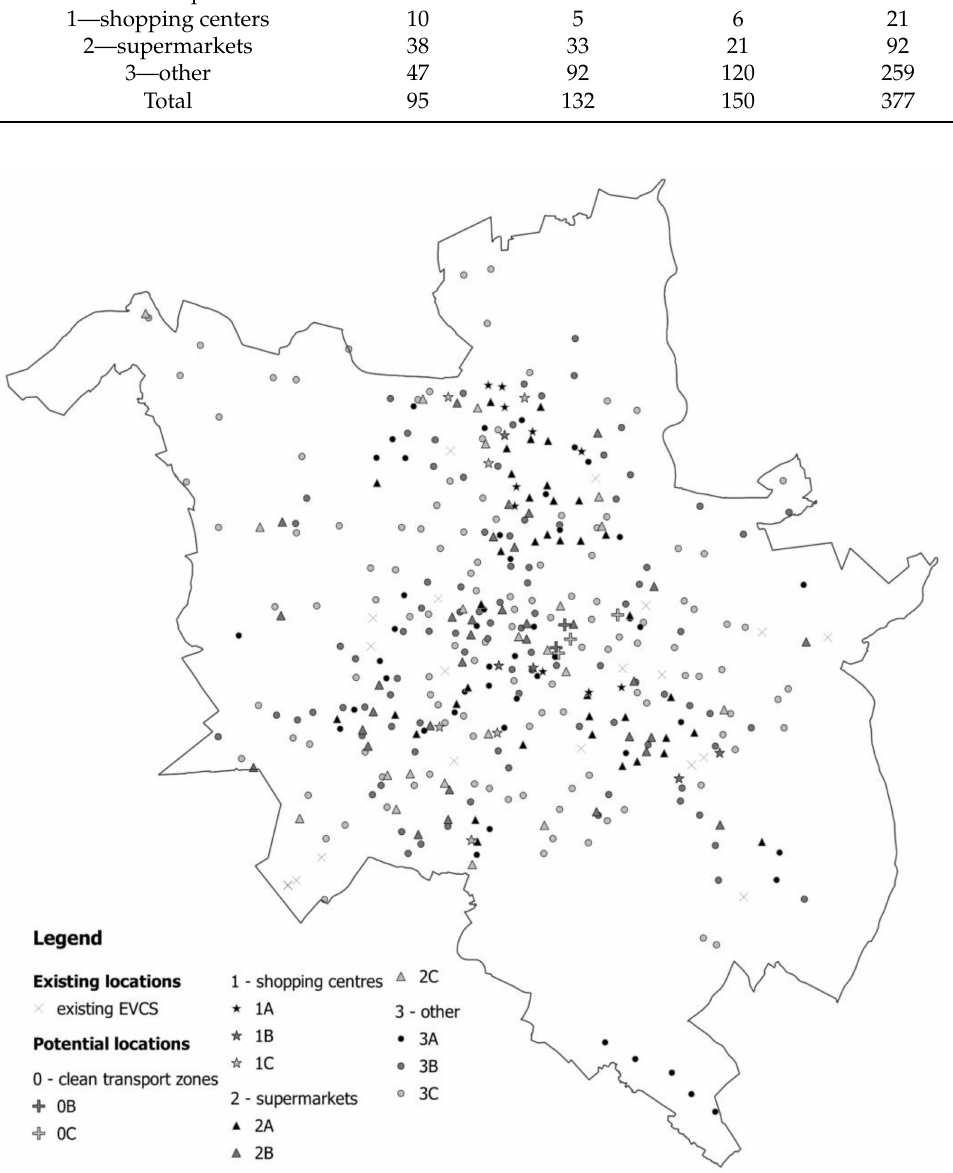
Figure 3. Locations of existing and potential EVCSs in Poznan. The mean Euclidean distance between all 397 locations (both existing and potential) was 373.6 m (min 11 m vs. max 1505 m), a noticeable distance from the point of view of potential users choosing a particular EVCS. The smallest distance applies to two existing locations (two different EVCS operators in one car park). Moreover, distances under 100 m occur for four pairs of potential locations. They are related to the presence of different facilities close to each other, such as a supermarket and a shopping center, where the variants where both locations have their own dedicated charging stations were specified to be acceptable. The longest distances to the nearest station occurred in potential locations on the outskirts of the